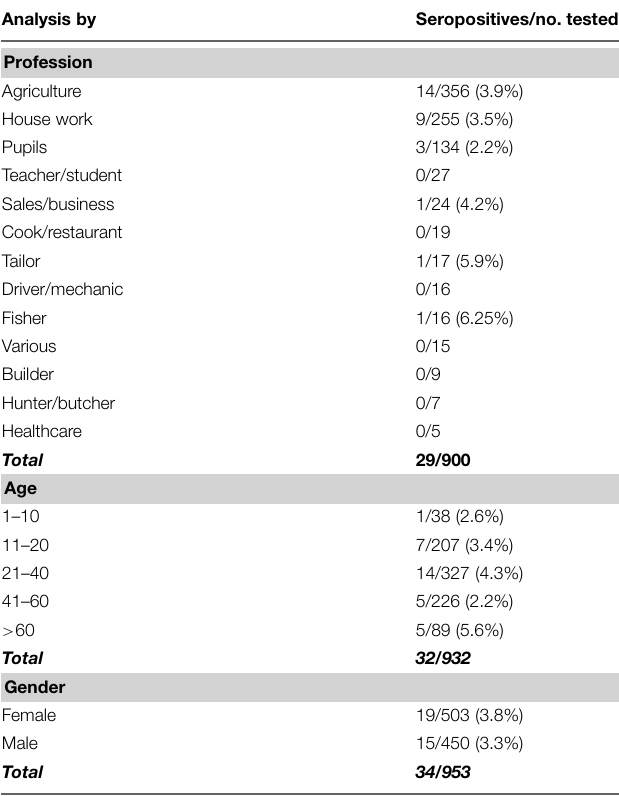
TABLE 2 | Seropositive participants from both study sites according to profession, age, and gender in both countries. Analysis by Seropositives/no.